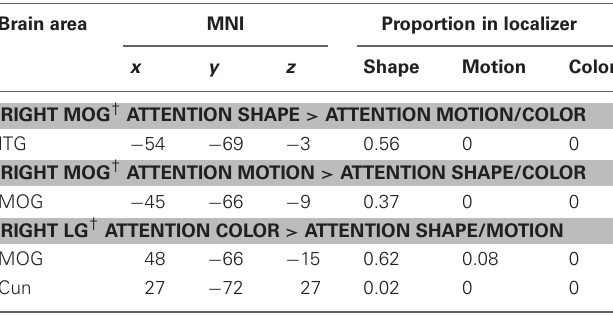
Table 5 | Target brain areas which showed a significant positive change in functional connectivity between seed and target areas on change blocks relative to no-change blocks.